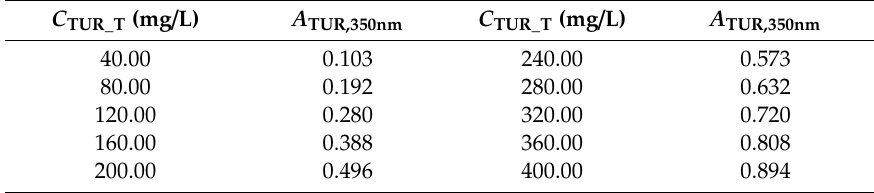
Table 9. Absorbance of di ff erent concentrations of TURB standard solution at 350 nm.